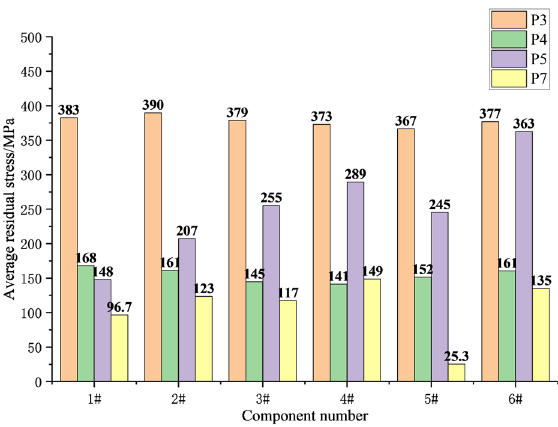
Figure 5. Average residual stress distribution of 1# to 6#.